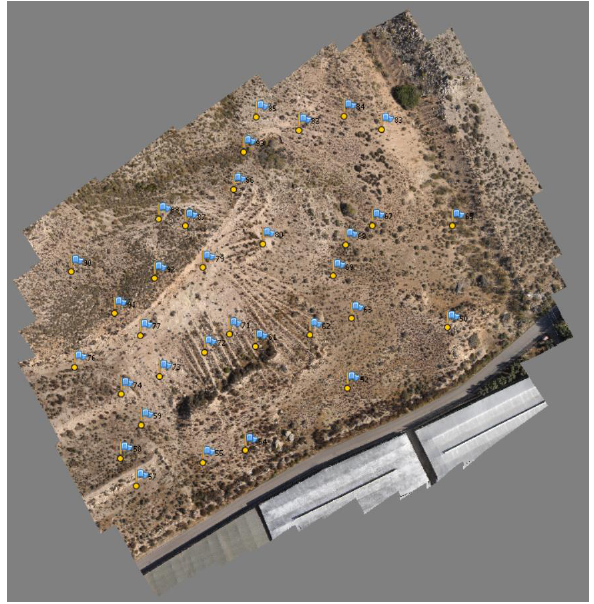
Figure 9. Check point distribution through the area study represented by flags, overlapped to de